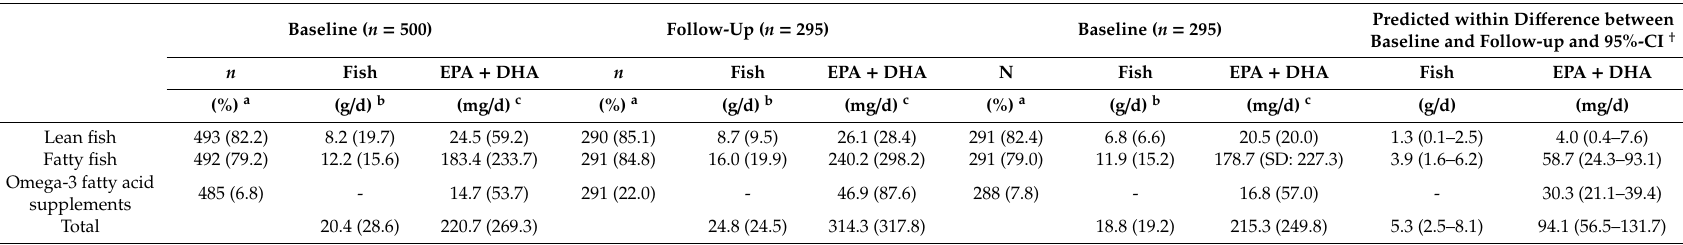
Table 2. Intake of fish and dietary supplements from dietary questionnaire and intake of eicosapentaenoic acid (EPA) + docosahexaenoic acid (DHA) derived thereof. Baseline ( n = 500) Follow-Up ( n = 295) Baseline ( n = 295) Predicted within Di